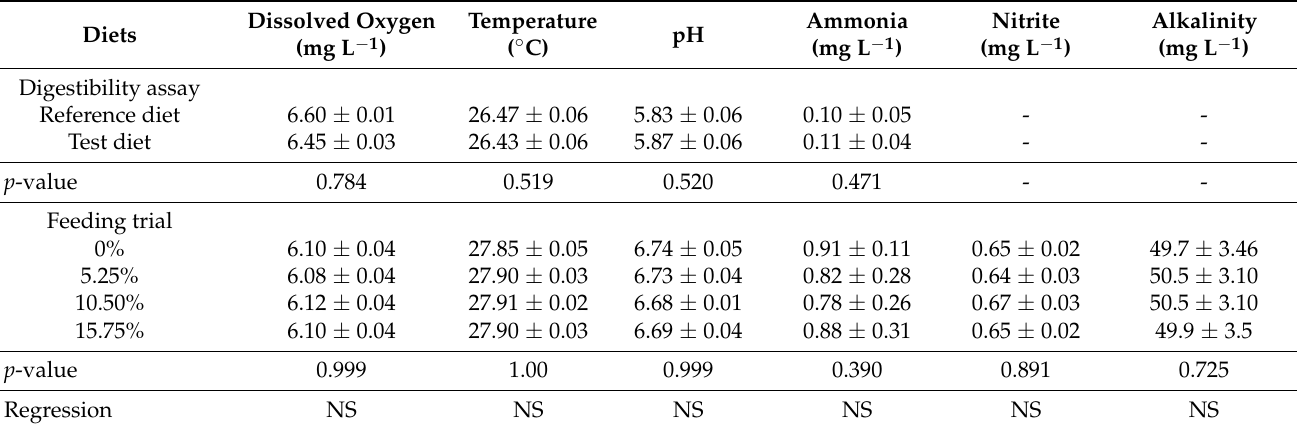
Table 3. Water quality parameters in rearing tambaqui fed diets containing full-fat black soldier fly Table 5. Growth performance and biometric indices of tambaqui fed diets containing graded levels of full-fat black soldier fly larvae (FF-BSFL) meal for 60 days. larvae (FF-BSFL) meal during the experimental period.